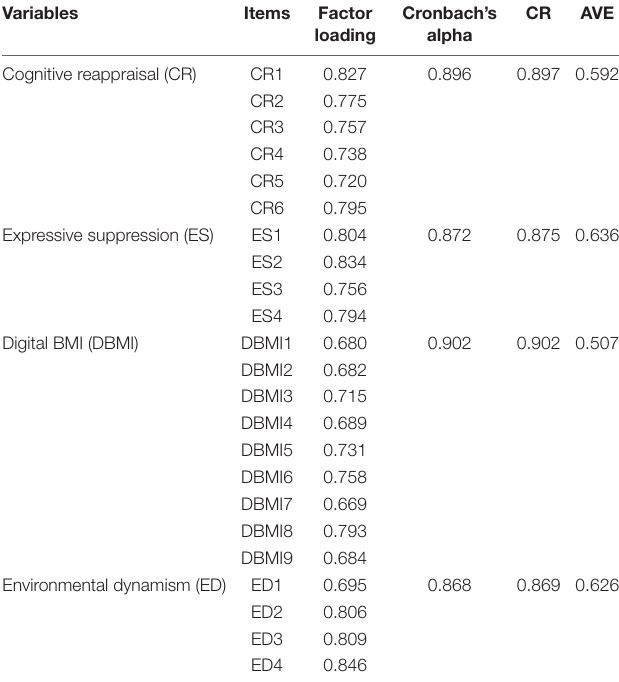
TABLE 1 | Reliability and validity.